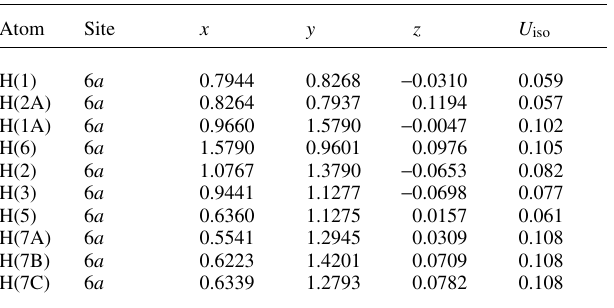
Table 2. Atomic coordinates and displacement parameters (in Å 2 )